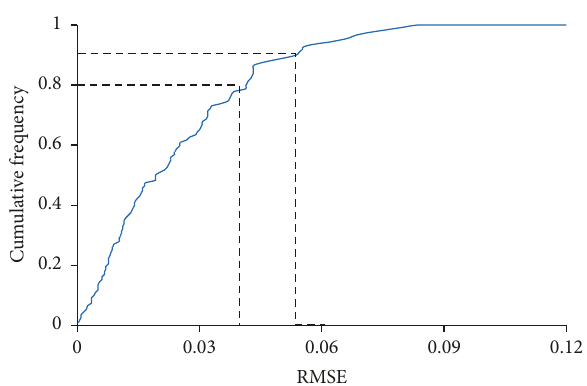
Figure 6: The travel time distribution of vehicles.